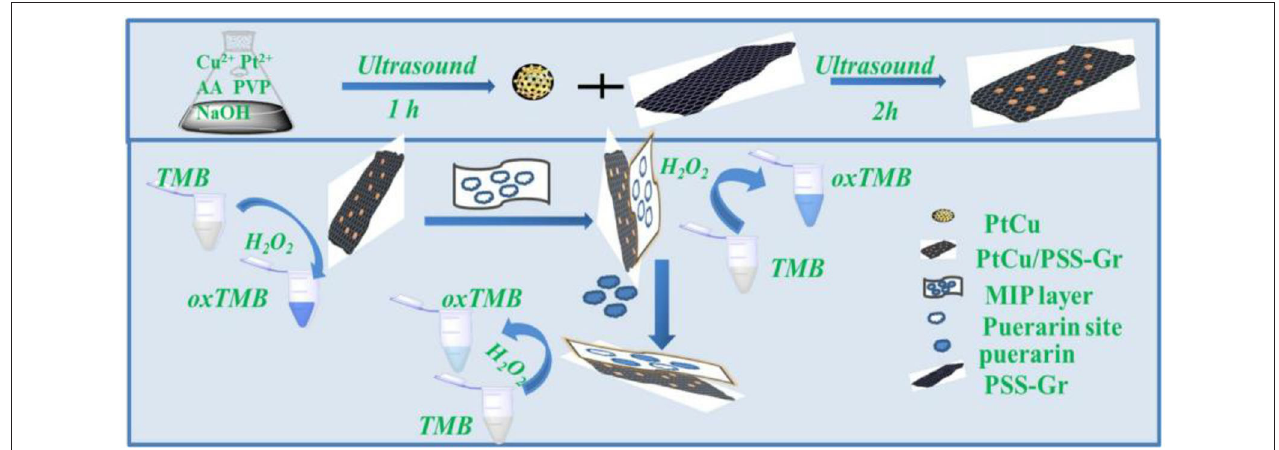
FIGURE 13 | Schematic diagram for the preparation of MIP@PtCu/PSS-Gr nanocomposite to detect puerarin (Guo et al., 2020). Reprinted with permission from Elsevier. Copyright (2020)